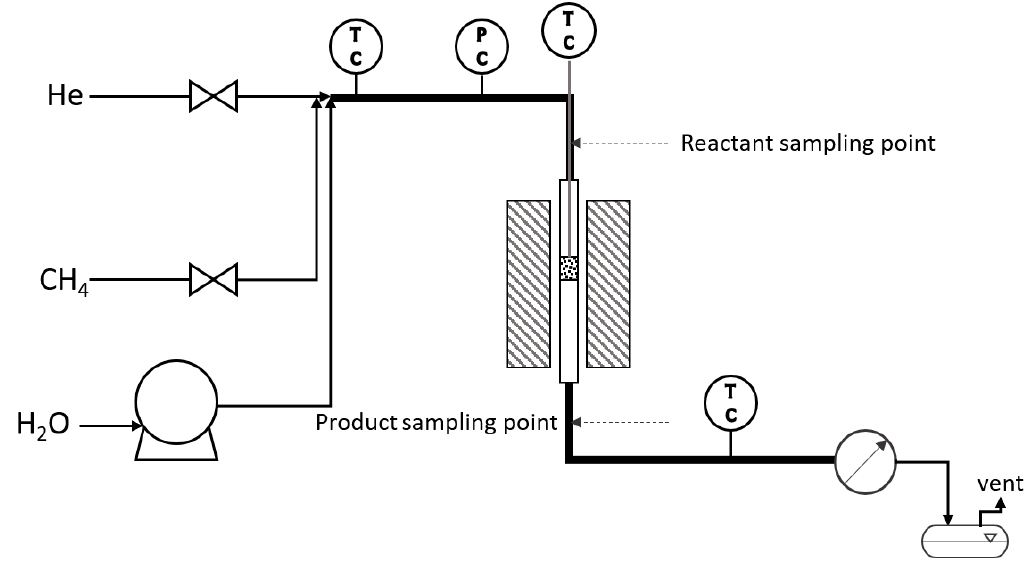
Figure 2. Schematic representation of the catalytic line used in the experiments.